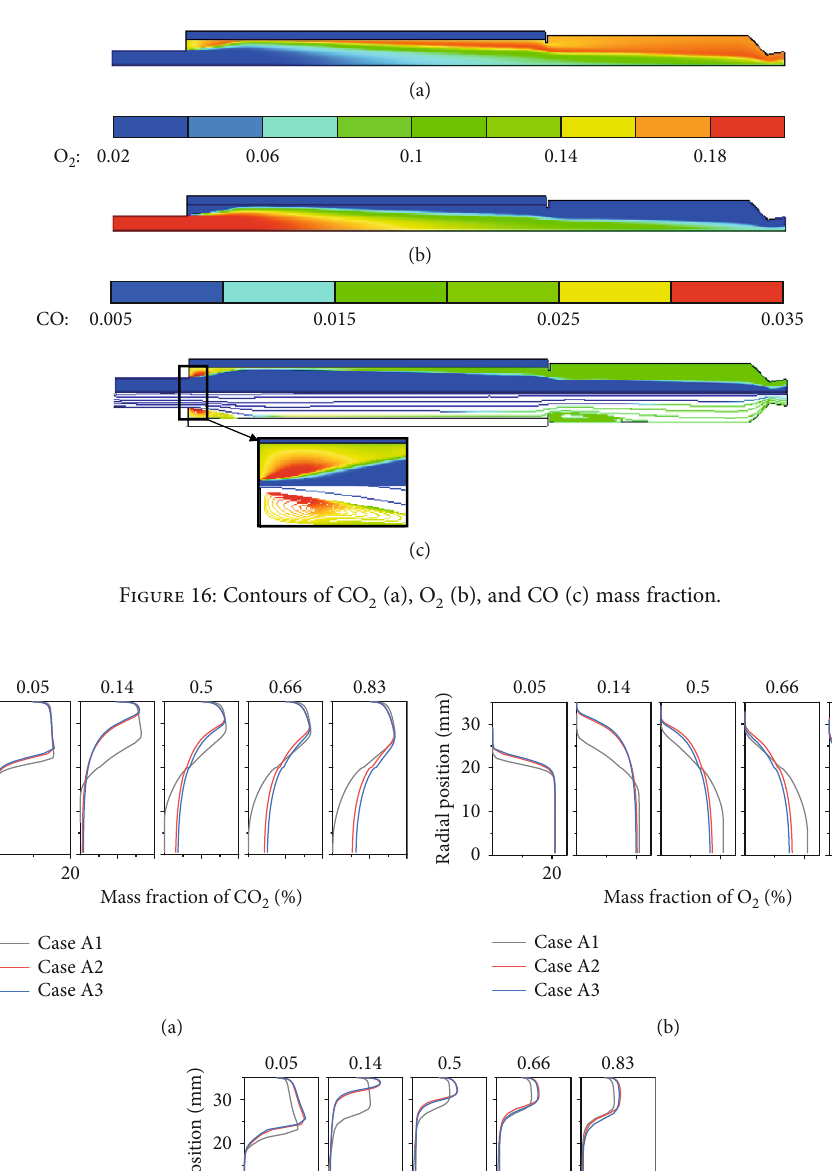
(a), O (b), and CO (c) for the cases with di ff erent inlet swirl numbers. 2 2